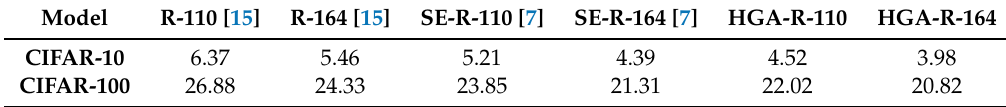
Table 4. Top 1 error(%) of different attention mechanism on CIFAR-10 and CIFAR-100 dataset.